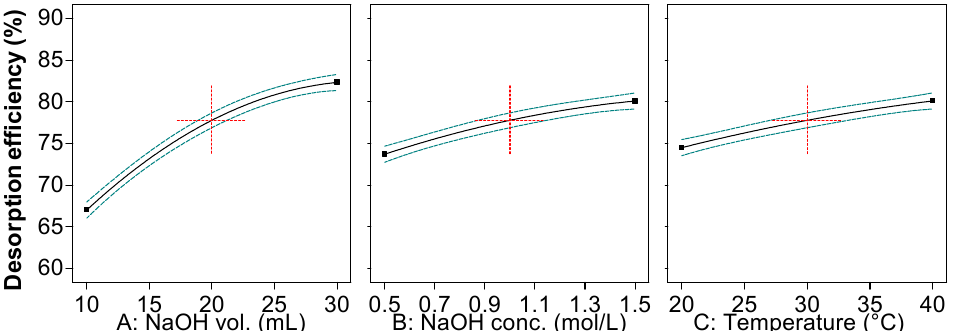
Figure 4. Experimental versus predicted values of RB desorption e ffi ciency.